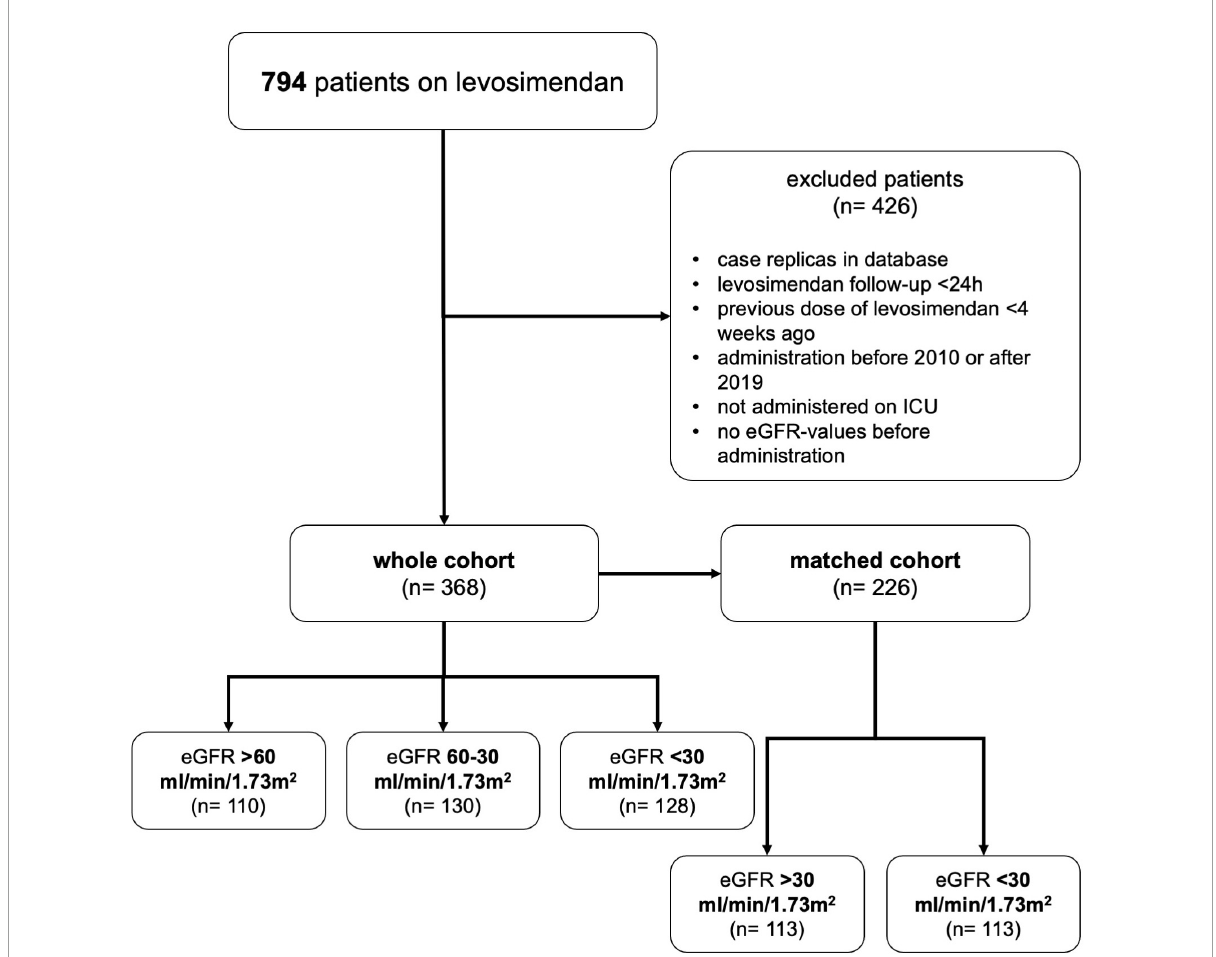
FIGURE1 Patient inclusion. Flow chart demonstrating how patients were assigned to groups by estimated glomerular filtration rate (eGFR). Reasons for exclusion are